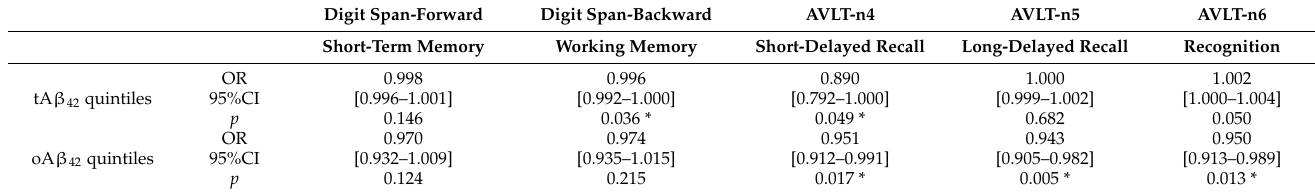
Table 5. Correlations of plasma A β 42 levels to cognitive